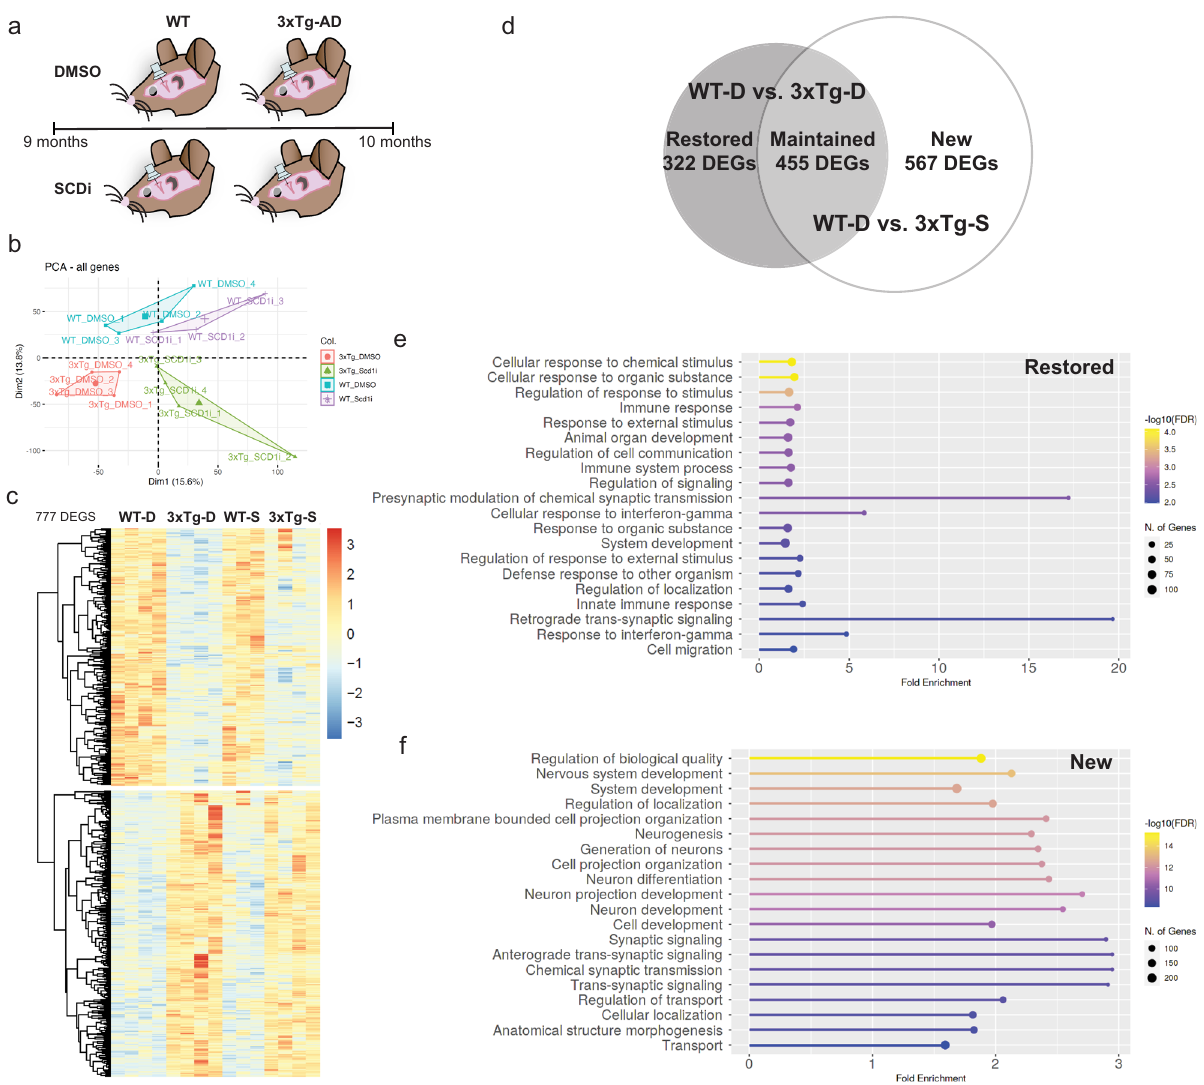
Fig. 2 SCDi infusion potently modulates gene expression in the 3xTg hippocampus, with main effects on immune- and synapse- related genes. a Timeline of intracerebroventricular infusion experiment on the 9-month-old WT and 3xTg mice infused with either vehicle (DMSO) or SCD inhibitor (SCDi). Hippocampi were extracted after 1 month infusion and processed for whole hippocampus bulk RNA sequencing. b Principal component analysis of the four experimental groups using the whole transcriptome ( “ all genes ” ). c Heatmaps of the 777 DEGs ( p ≤ 0.01) between WT-D and 3xTg-D groups, with DEG expression shown across the four treatment groups ( n = 4 mice/group). d Venn diagram showing the overlap of the WT-D/3xTg-D and WT-D/ 3xTg-S DEG lists, in order to identify DEGs that are “ Restored ” (no longer signi fi cant), “ Maintained ” (still signi fi cant), or “ New ” (newly appearing) after SCDi infusion into 3xTg mice. e , f GO enrichment analysis showing the top 20 most enriched GO biological process gene sets for the “ Restored ” DEGs ( e ) and “ New ” DEGs ( f ) in SCDi-infused 3xTg mice. Restored gene were mainly enriched in GO Biological Process gene sets related to cellular response to stimuli, immunity and synapses ( e ) while the newly changed genes were mainly enriched in GO biological process gene sets related to nervous system development and synapses ( f ). See Supplemental Data File 2 for complete DEG